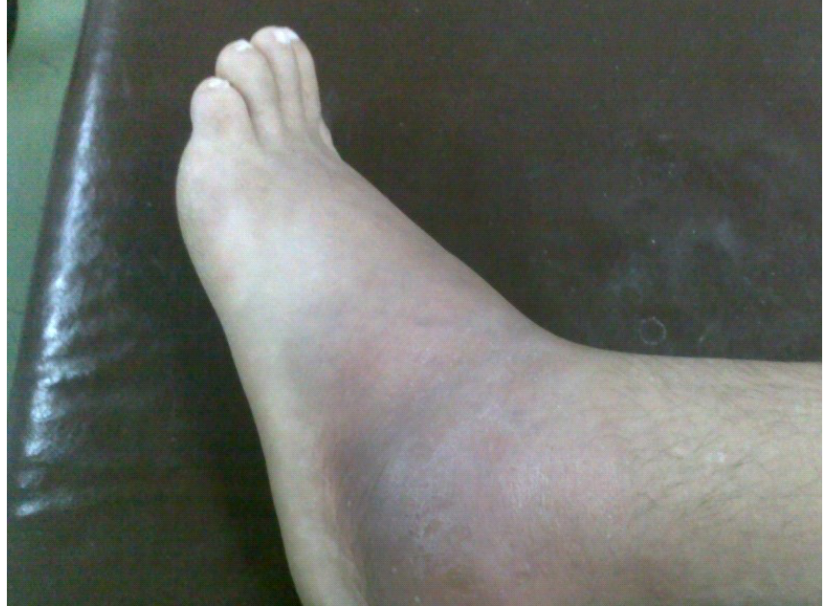
Figure 1. Swelling and erythema in the area of left lateral malleolar region with propagation in the foot.